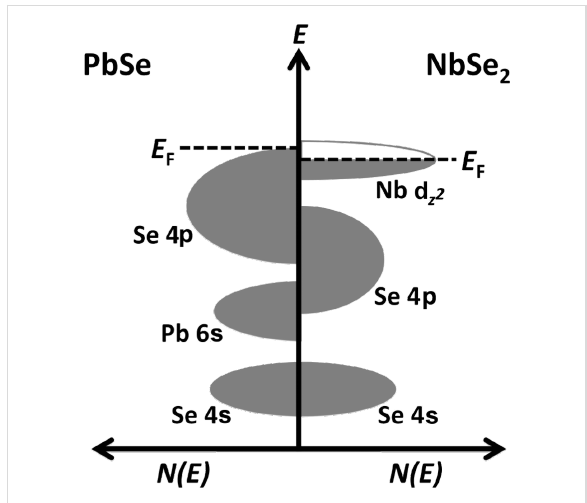
Figure 5: Schematic representation of the density of states of a PbSe layer (left) and a NbSe 2 layer (right). The electron transfer takes place from the PbSe valance band to the conduction band of the NbSe 2 layer. Adapted with permission from [36]. Copyright 2014 American Chemical